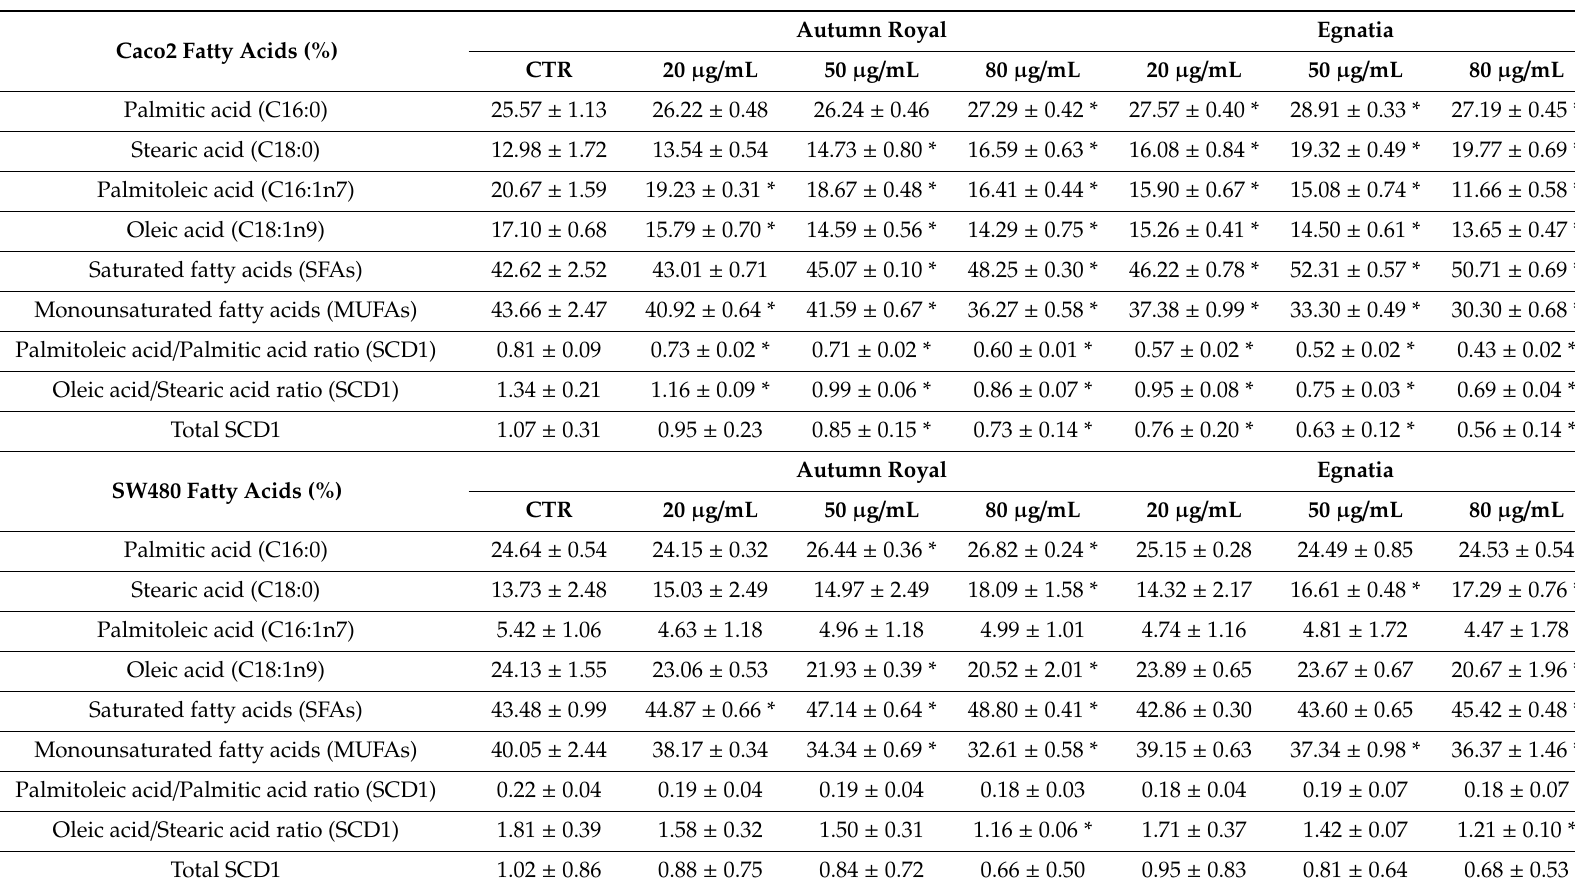
Table 2. (a) Mean percentage of main saturated and monounsaturated fatty acids in Caco2 membrane cell lines treated with increasing concentrations of Autumn royal and Egnatia GSEs (20, 50, and 80 µ g / mL) for 48 h; (b) Mean percentage of main saturated and monounsaturated fatty acids in SW480 membrane cell lines treated with increasing concentrations of Autumn royal and Egnatia GSEs (20, 50, and 80 µ g / mL) for 48